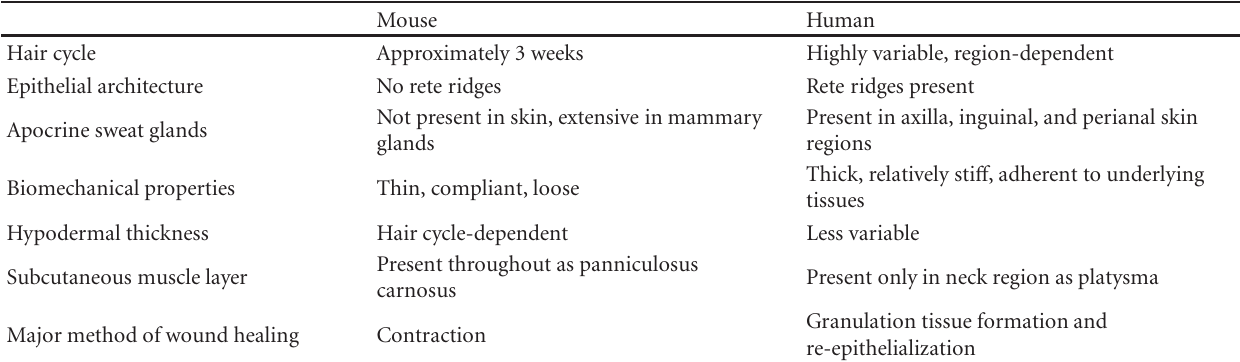
Table 1: Major di ff erences between mouse and human